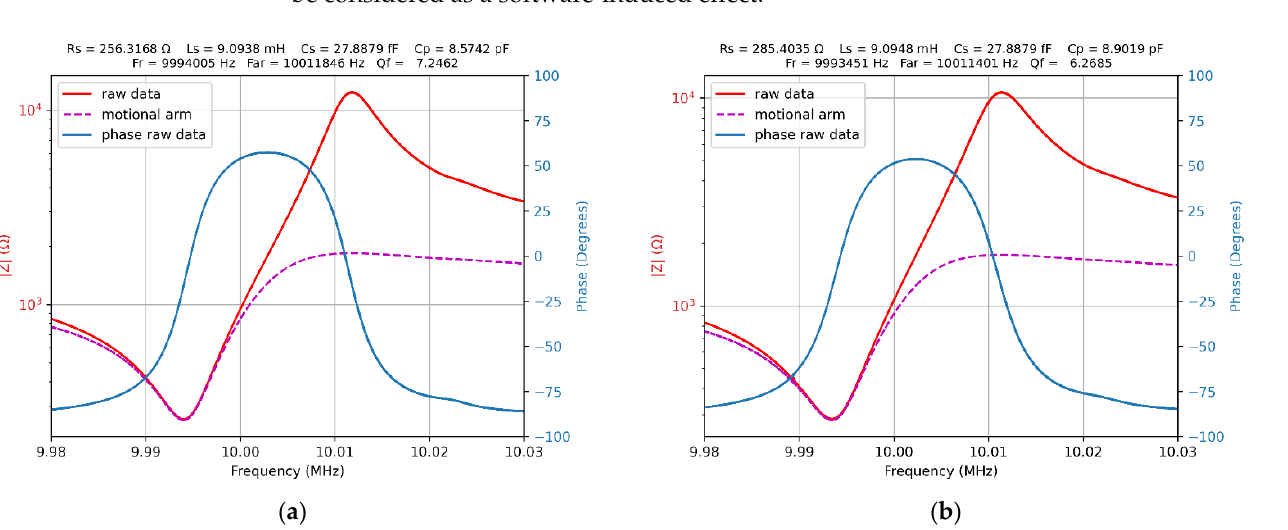
Figure 10. ( a ) Impedance and phase of the QCM sensor in water. ( b ) Impedance and phase of the QCM sensor in 15% glycerol – water solution.